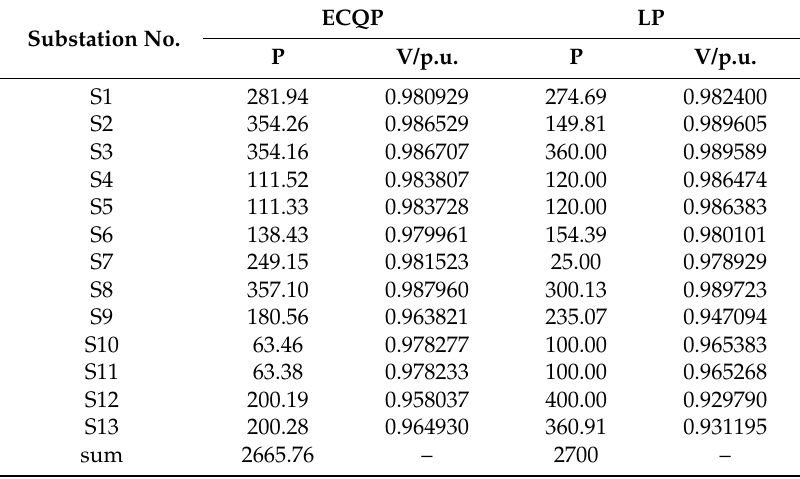
Table 3. Comparison of solutions obtained by ECQP and LP.